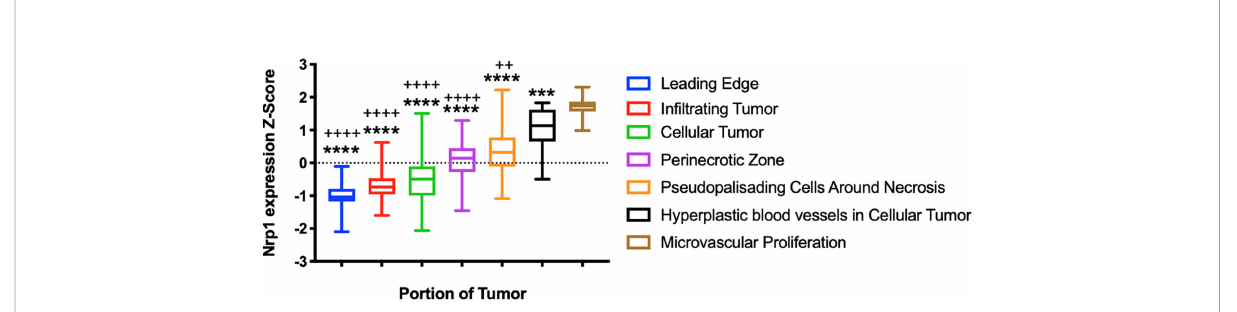
FIGURE 2 Neuropilin-1 in Glioblastoma. A) Relative expression of Nrp1 across glioblastoma tumor areas. ****p < 0.0001 ANOVA, demonstrating signi fi cant differences in expression across glioblastoma tumor areas. ++p < 0.01, ++++p < 0.0001, Brown-Forsythe test compared to Nrp1 expression in hyperplastic blood vessels. ***p < 0.001, ****p < 0.0001, Brown-Forsythe test compared to Nrp1 expression in areas of microvascular proliferation. Analysis from the Ivy Glioblastoma Atlas Project data